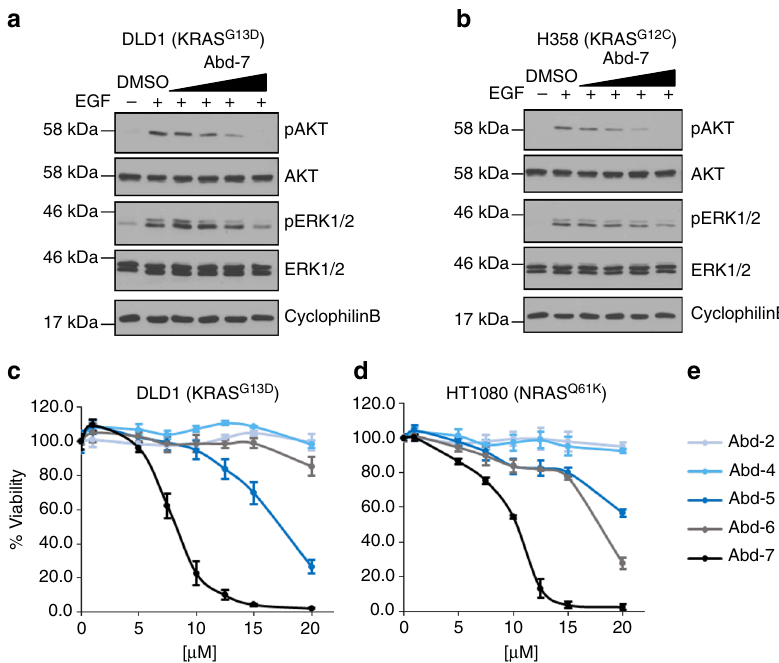
Fig. 5 Abd-7 results on RAS-dependent signalling pathways and cell viability. a , b DLD-1 ( a ) or H358 ( b ) cells were serum-starved for 24 h, incubated in mono-layer with Abd-7 in a range from 2, 5, 10 and 20 μ M for 3 h and stimulated with EGF 10 min. Proteins were extracted and separated by SDS-PAGE and transferred to membranes for Western analysis with anti-pAKT, anti-pERK, anti-pan AKT and anti-pan ERK. Anti-cyclophilin B antibody was the loading control. Signal was developed using standard ECL. c – e Effects of compounds Abd-2, Abd-4, Abd-5, Abd-6, and Abd-7 on the viability of human cancer cells lines was assessed for a 2-D culture of DLD-1 (mutant KRAS G13D ) cells and HT1080 cells (mutant NRAS Q61K ). The cells were treated with a dose range from 0 μ M to 20 μ and incubated for 72 h when cell viability was assessed using CellTitreGlo. In each case, the data are normalized to cells treated with DMSO only. c is DLD-1 and d is HT1080. e shows the colour coding for the different compounds. Each experiment was repeated at least three times ( a , b ) and four times ( c, d ). Where error bars are presented, they correspond to mean values± SD of biological